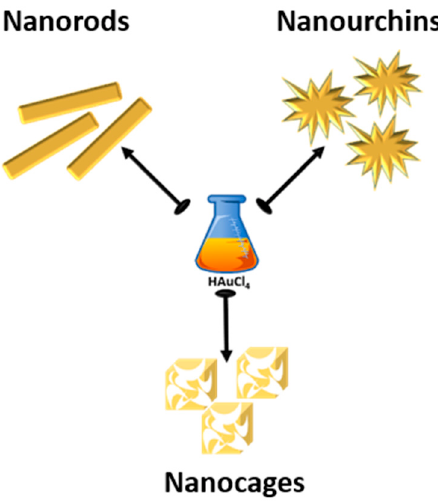
Figure 2. Anisotropic gold nanoparticles considered in the present review: nanorods, nanourchins and nanocages.